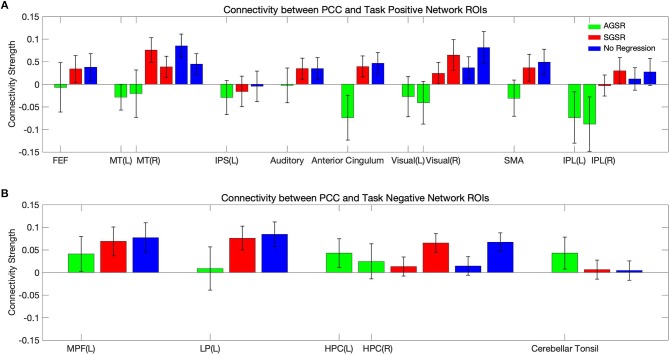
The average connectivity map between the PCC as a seed region and (A) the TPN and (B) TNN ROIs for fMRI data of all subjects. Connectivity results of applying AGSR and SGSR are shown in green and red, respectively, and the blue ones are the results of computing connectivity without applying any GSR (NR). Connectivity map is made by computing Pearson's correlation coefficient (r) with P ≤ 0.01 between the PCC region as a seed region and the main regions of the TPN and TNN. PCC, Posterior Cingulate Cortex; MPF, Medial Prefrontal cortex; LP, Lateral Parietal cortex; MT, Middle Temporal; FEF, Frontal Eye Field; IPS, Intraparietal Sulcus; SMA, Supplementary Motor Area; IPL, Inferior Parietal Lobule; ROI, Region Of Interest; NR, No Regression; AGS, Adaptive Global Signal Regression; SGS, Static (conventional) Global Signal Regression.